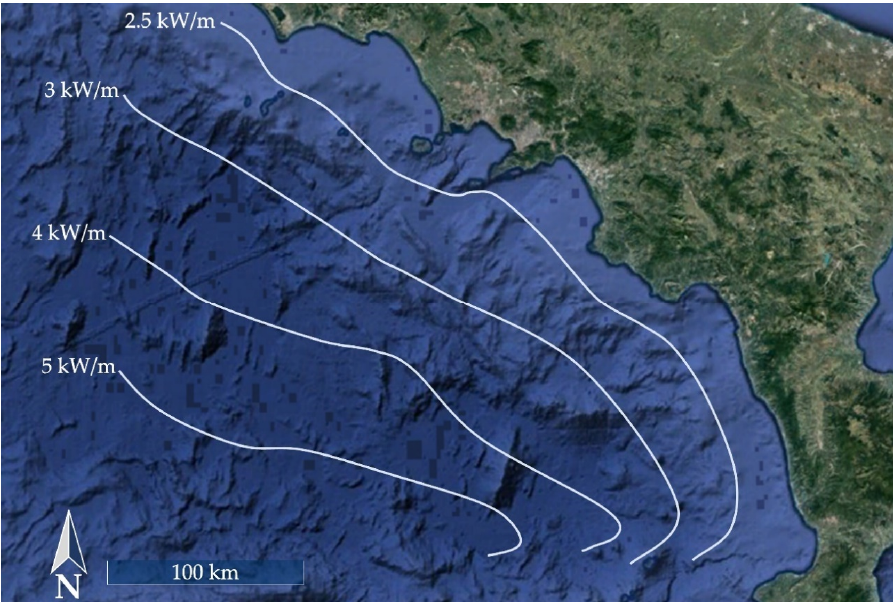
Figure 4. The 18-year averaged energy flux for the 12 ECMWF grid points and contour lines of the estimated mean wave power flux per unit crest on the central and southern Tyrrhenian Sea.